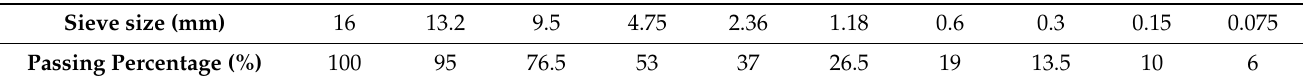
Table 2. Gradation of